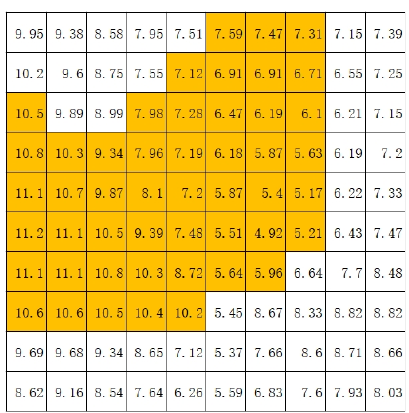
Figure 4. Part of scores in each grid of the map.